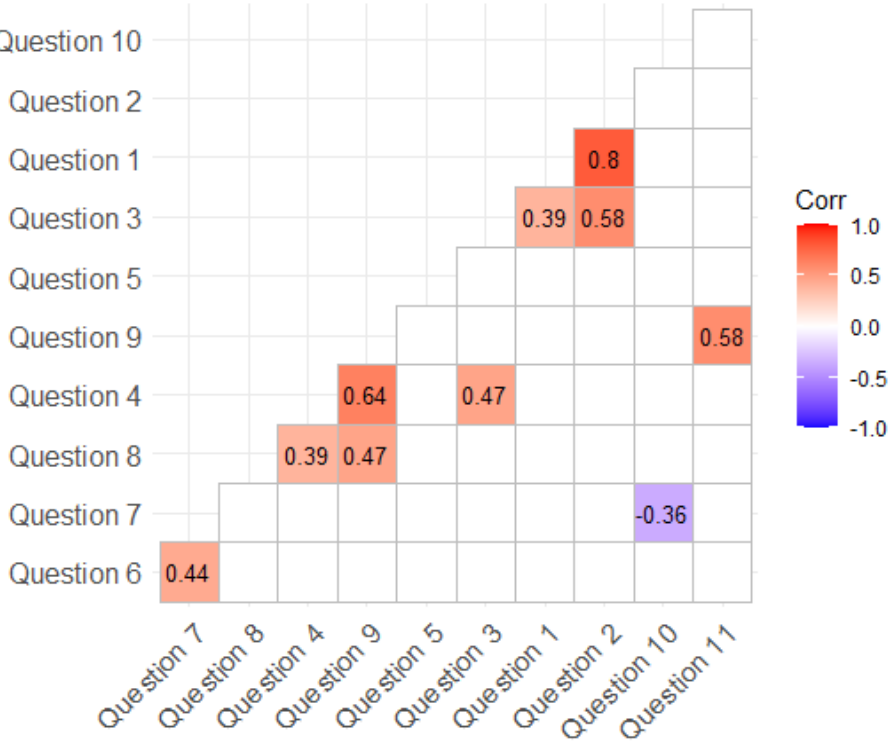
Figure 5. Statistically significant correlations between answers to the post-experience survey ques- tions for all participants ( n = 30). Statistically insignificant correlations ( p > 0.05) were